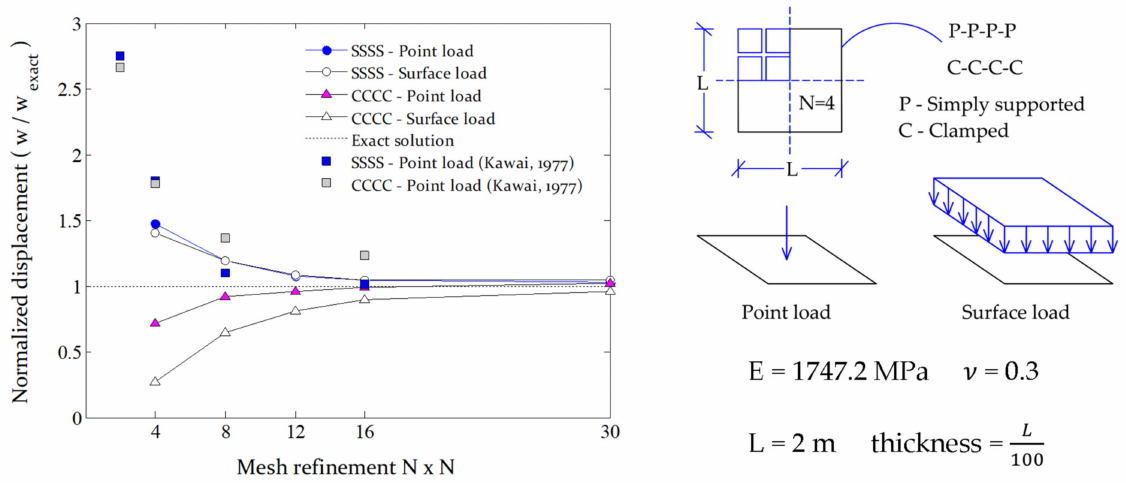
Figure 5. Convergence study conducted for a squared plate